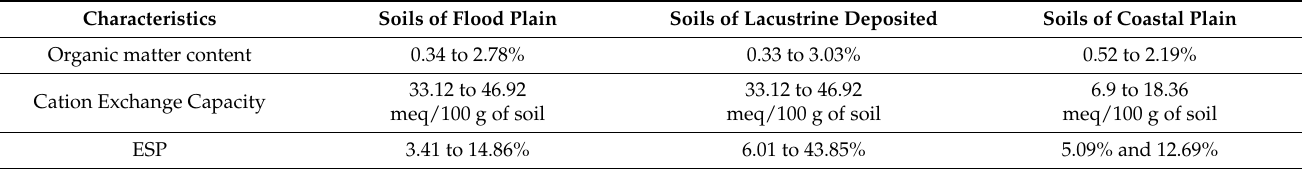
Table 5. Cont . Table 6. Areas and frequencies of soil sub-groups in Kafr El Sheikh Governorate.